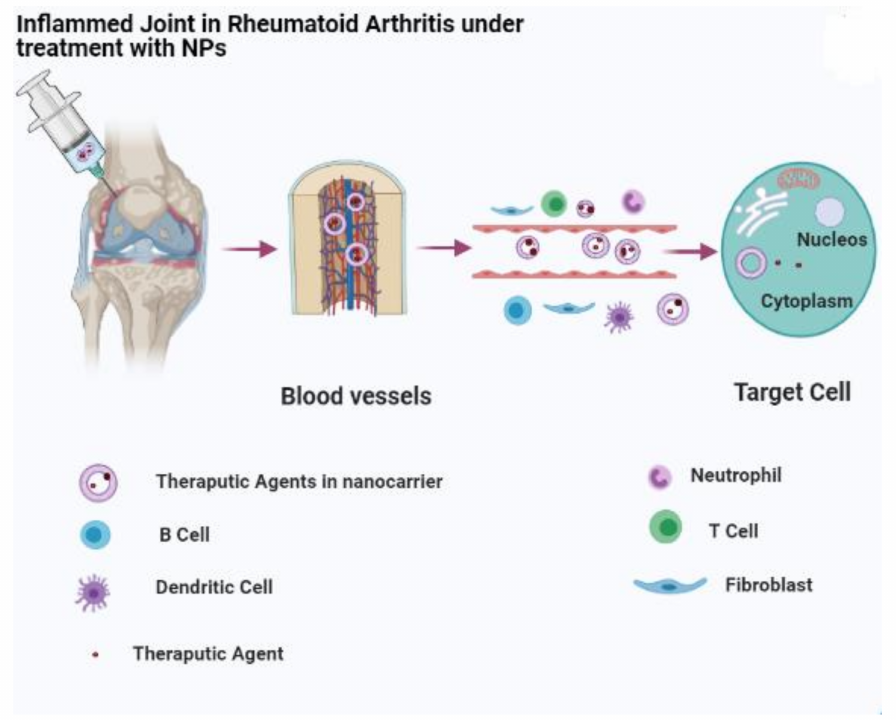
Figure 2. Liposomes as nanocarriers for the delivery of drugs in the treatment of